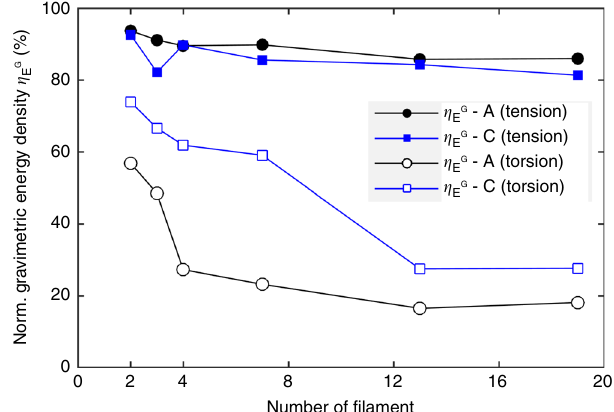
Fig. 6 Different deformation strain components. The theoretical predic- tions of the strain components as a function of the torsional strain for nanothread-A